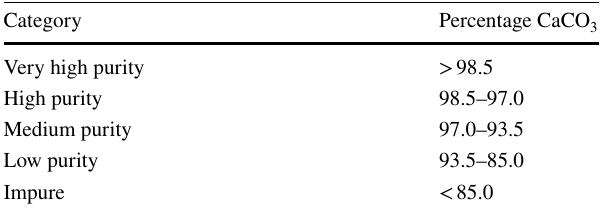
Table 5 Classification of limestone by calcium carbonate content as in Bloodworth (2002)